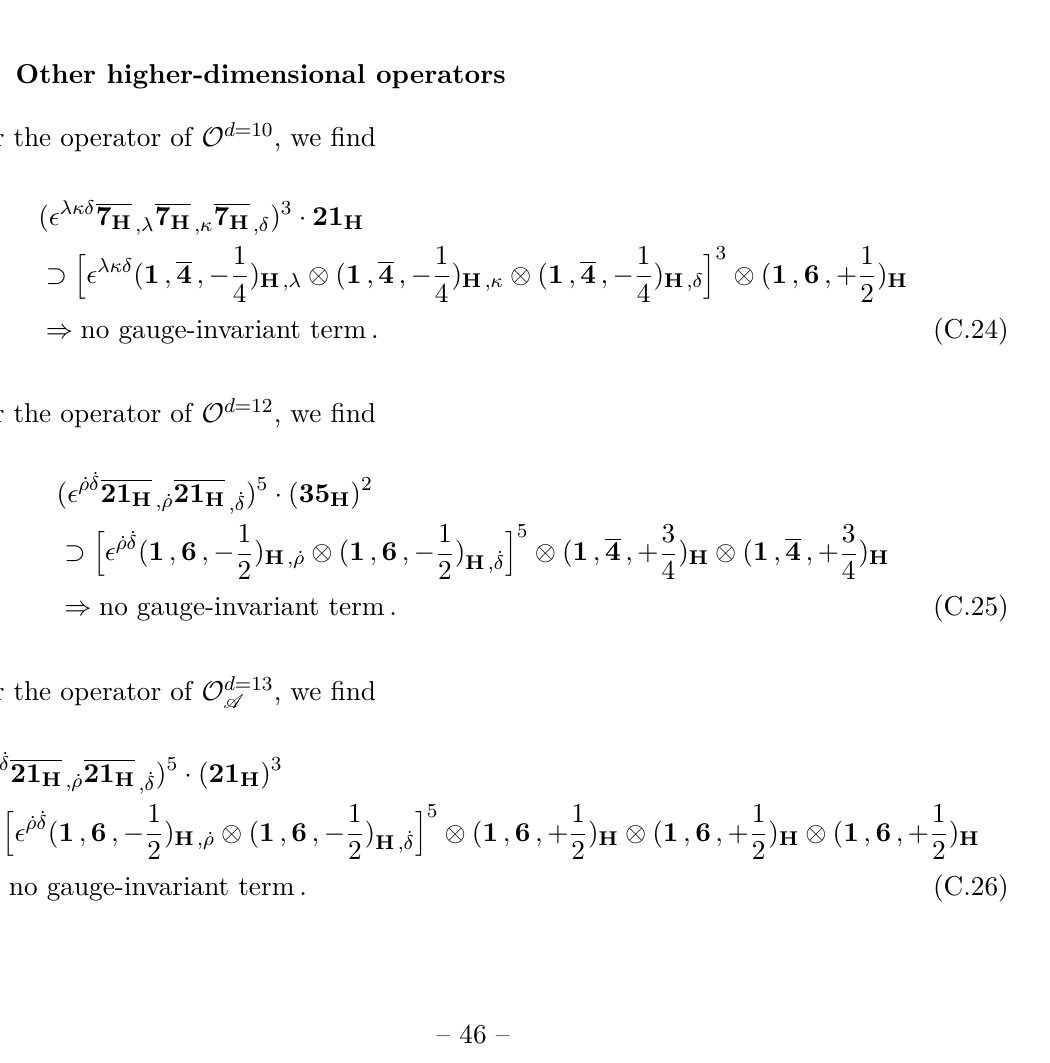
= q = 0 and q = − 1 p 2 6 = 0 are marked 1 1 2 2